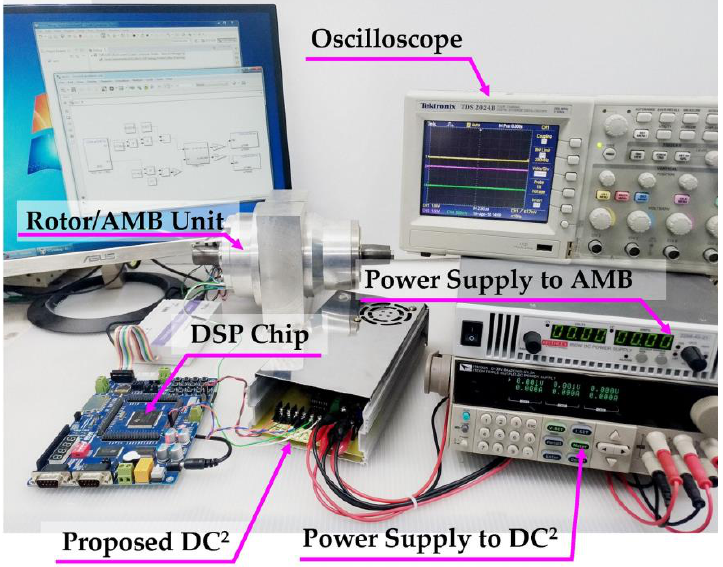
Figure 13. Experimental setup.